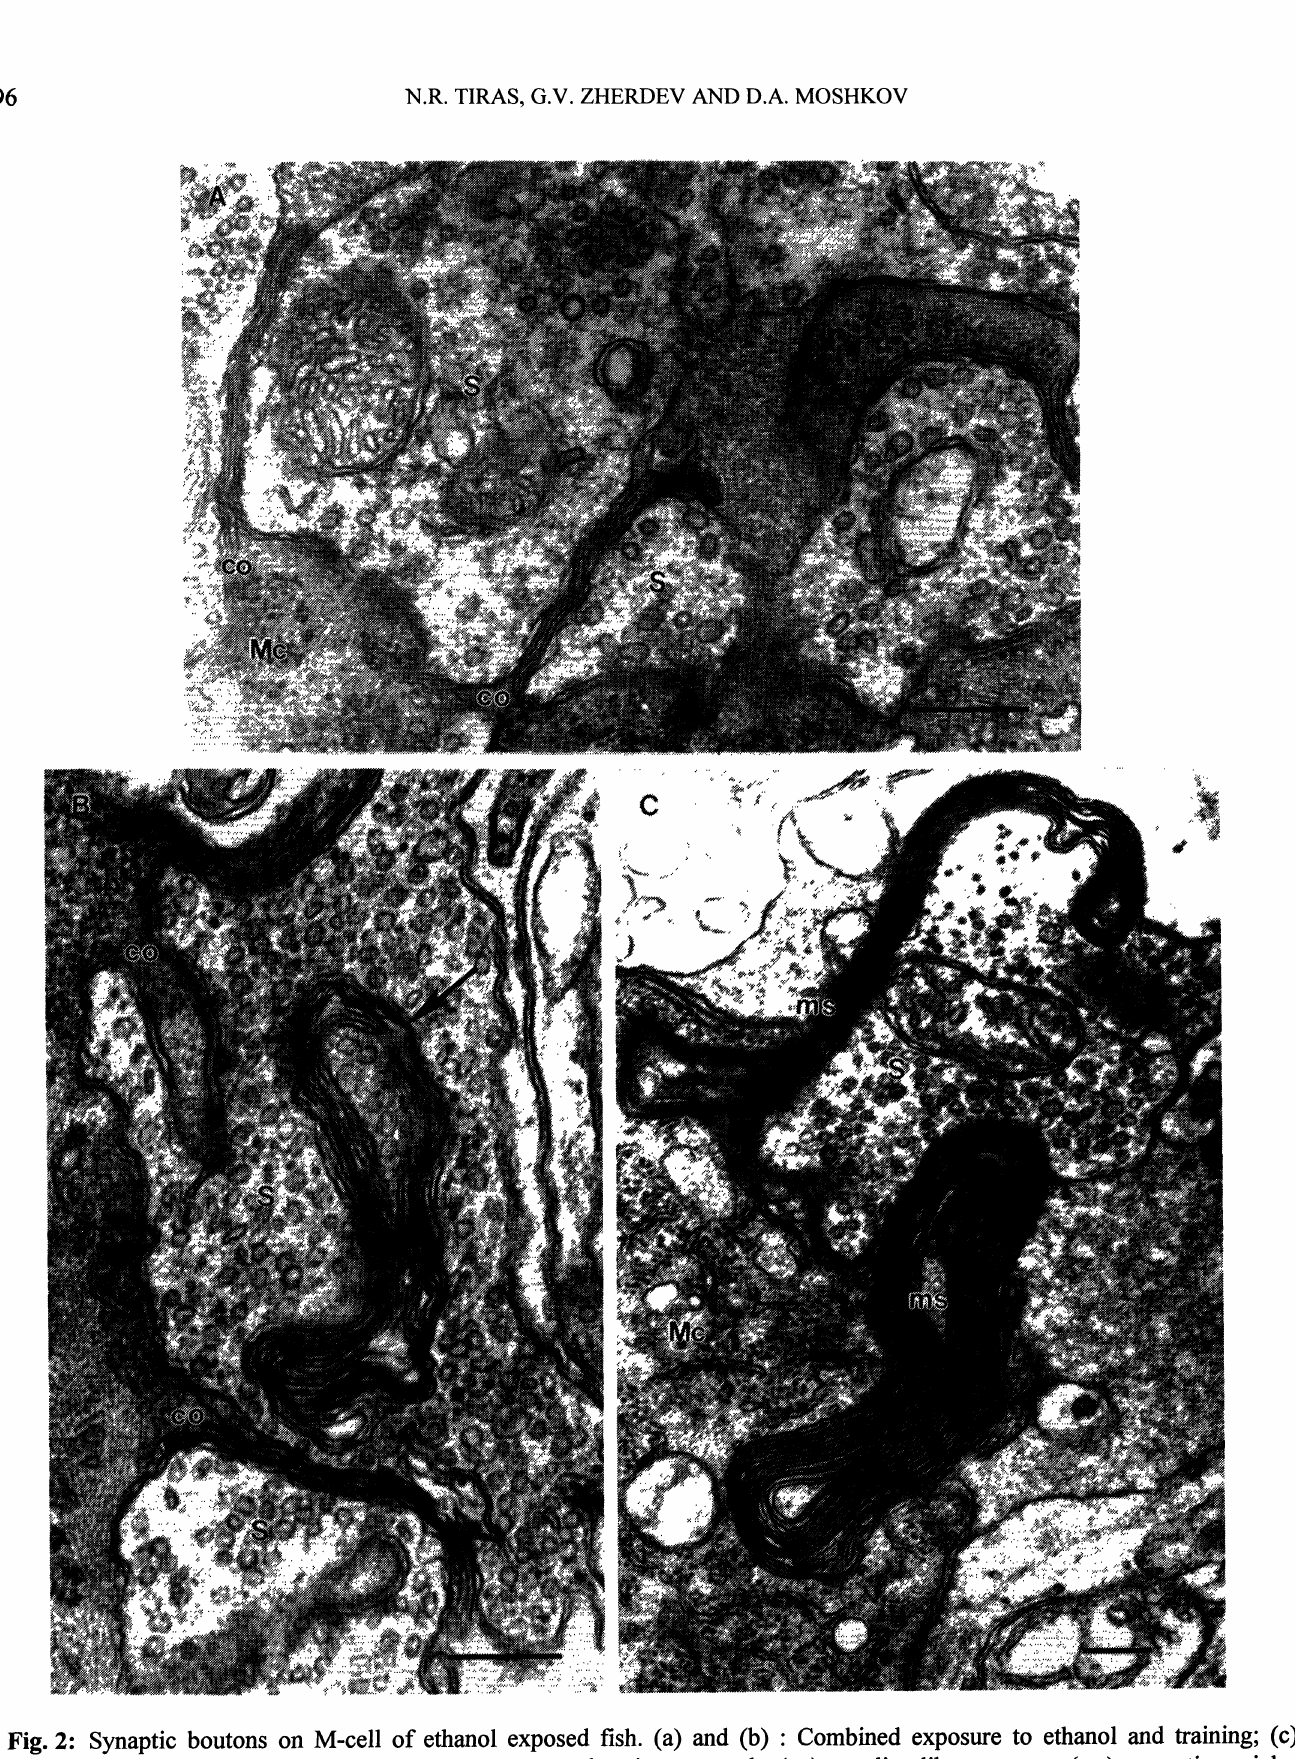
Fig. 2" Synaptic boutons on M-cell of ethanol exposed fish. (a) and (b) Combined exposure to ethanol and training; (c) Exposure to ethanol without training. Note cytoplasmic outgrowths (co), myeline-like structures (ms), synaptic vesicles separated by membranes (arrow). Abbreviations as in Fig. 1. Scale bar 0.25